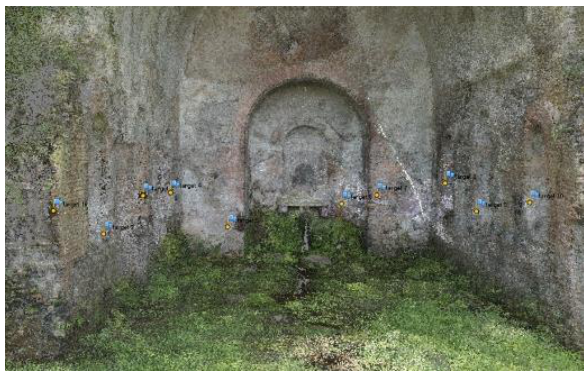
Figure 1. Sparse point cloud with markers location The main photographic campaign was carried out with a Nikon D800E SLR camera and a 35 mm lens. The shooting settings Figure 3. Location of the Nymphaeum in the Caffarella Park are as follow: 200 ISO, F/6.3 aperture and 1/100 shutter. 683 photos were taken from different points of view: both from the Nymphaeum level and from the walkway facing it (Fig. 2). Its orientation, together with the orography of the place, means that the three main sides of the structure are permanently in shadow. Considering these environmental conditions, the thermographic data were acquired passively. In this case, the measurement is carried out only once because the thermal behavior of the structure is not affected by solar radiation. Two campaigns were carried out and, in both cases, a Testo 875i thermal camera was used, which simultaneously records the thermal and RGB data of the objects photographed. During the first campaign, the lower band of the south-west wall and, partially, of the south-east and north-west walls was recorded, up to a height equal to half of the niches of the side walls. The thermal camera was positioned at a fixed distance from the walls to keep the Ground Sampling Distance (GSD) constant in all shots. For the same reason, the images were taken as perpendicular as possible to the surface, to avoid excessive distortion of the projected pixel. In the first campaign, the acquisitions were carried out keeping a distance of about 2 meters from the walls of the structure and 56 images were taken. It was also decided to plan a second campaign to investigate in greater detail a clay pipe, partially visible in the north-east wall. 93 images were taken at about 50 cm from the wall in question. The purpose of the new acquisition was to read the path of the pipe that in the first campaign did not produce results because the thermal difference between the areas of full masonry and those with the pipe inside them was almost Figure 2. Sparse point cloud with cameras location Two other photo campaigns were conducted with a Nikon D3300 camera and the integrated camera of a Huawei P10 smartphone. The latter two acquisition were used to compare the results obtained from the processing of each of the three different sensors. The images of the D800E camera were used as a benchmark to assess the impact of the photographic sensor on the metric and geometric reliability of the reconstructed